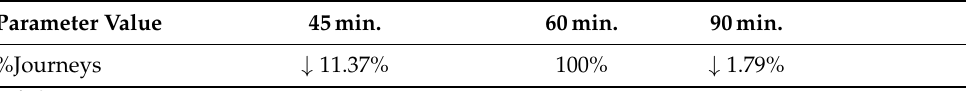
Table 2. Sensitivity Analysis of the Time Threshold δ T . Parameter Value 45min. 60min. 90min. %Journeys